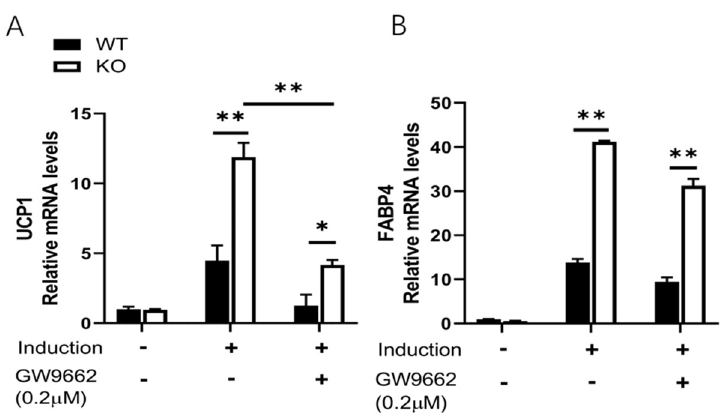
Figure 5. Blocking PPAR- γ activity reduces rosiglitazone-induced UCP-1 expression in SPL KO adipocytes. Relative expression of UCP1 ( A ), and FABP4 ( B ) in the presence or absence of rosigli- tazone (induction) and/or GW9662. SVF cells were pre-treated with 0.2 µ M GW9662 for 6 h, then cultured in browning induction media. Two-way ANOVA with Tukey-Kramer post hoc test was performed to compare differences. * p < 0.05, ** p < 0.01. All data are presented as means ±